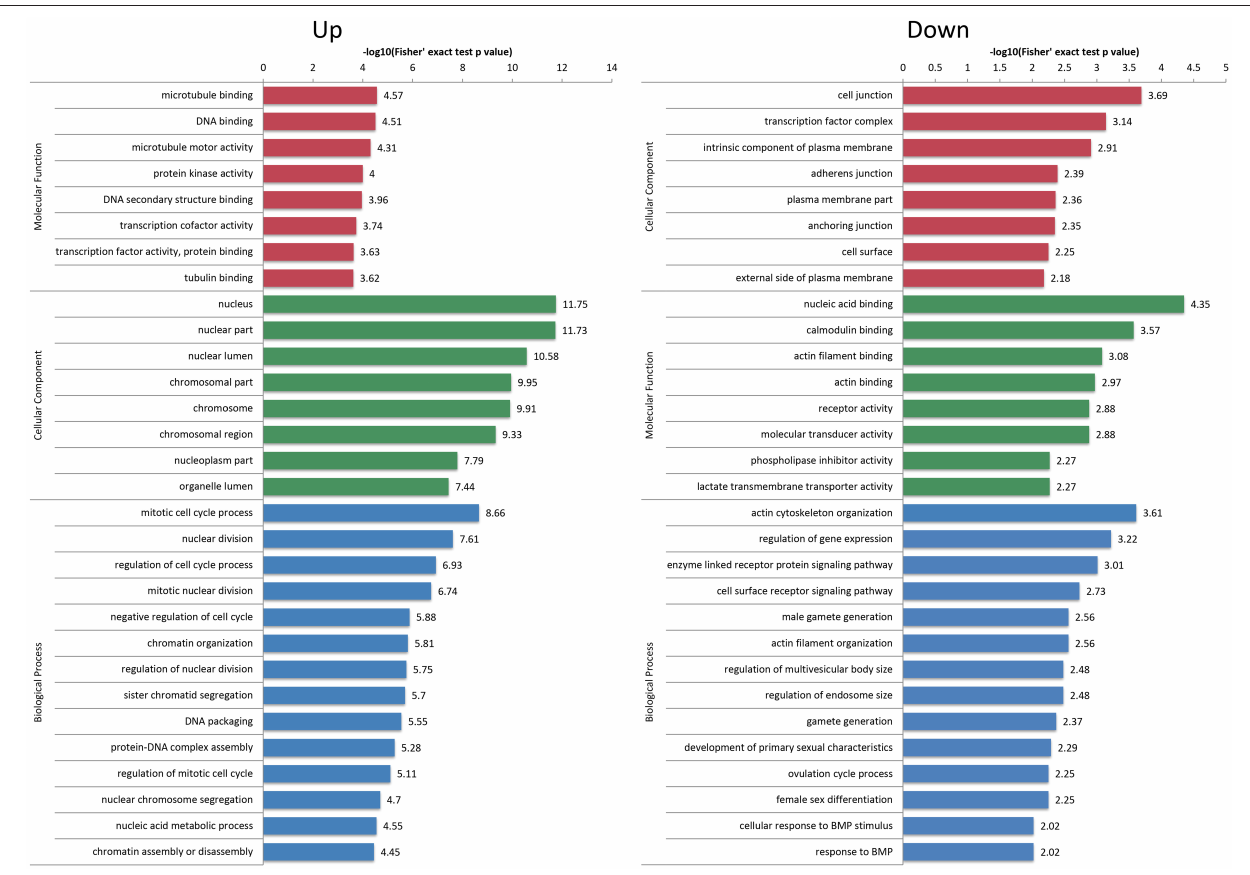
FIGURE 4 | Gene Ontology (GO) enrichment analysis of differentially expressed proteins (DEPs). The over-expressed and under-expressed DEPs were enriched into cellular component, molecular function and biological process. The bar represents the enrichment score associated with each term, and score value is shown as -log10 (Fisher’s exact test P